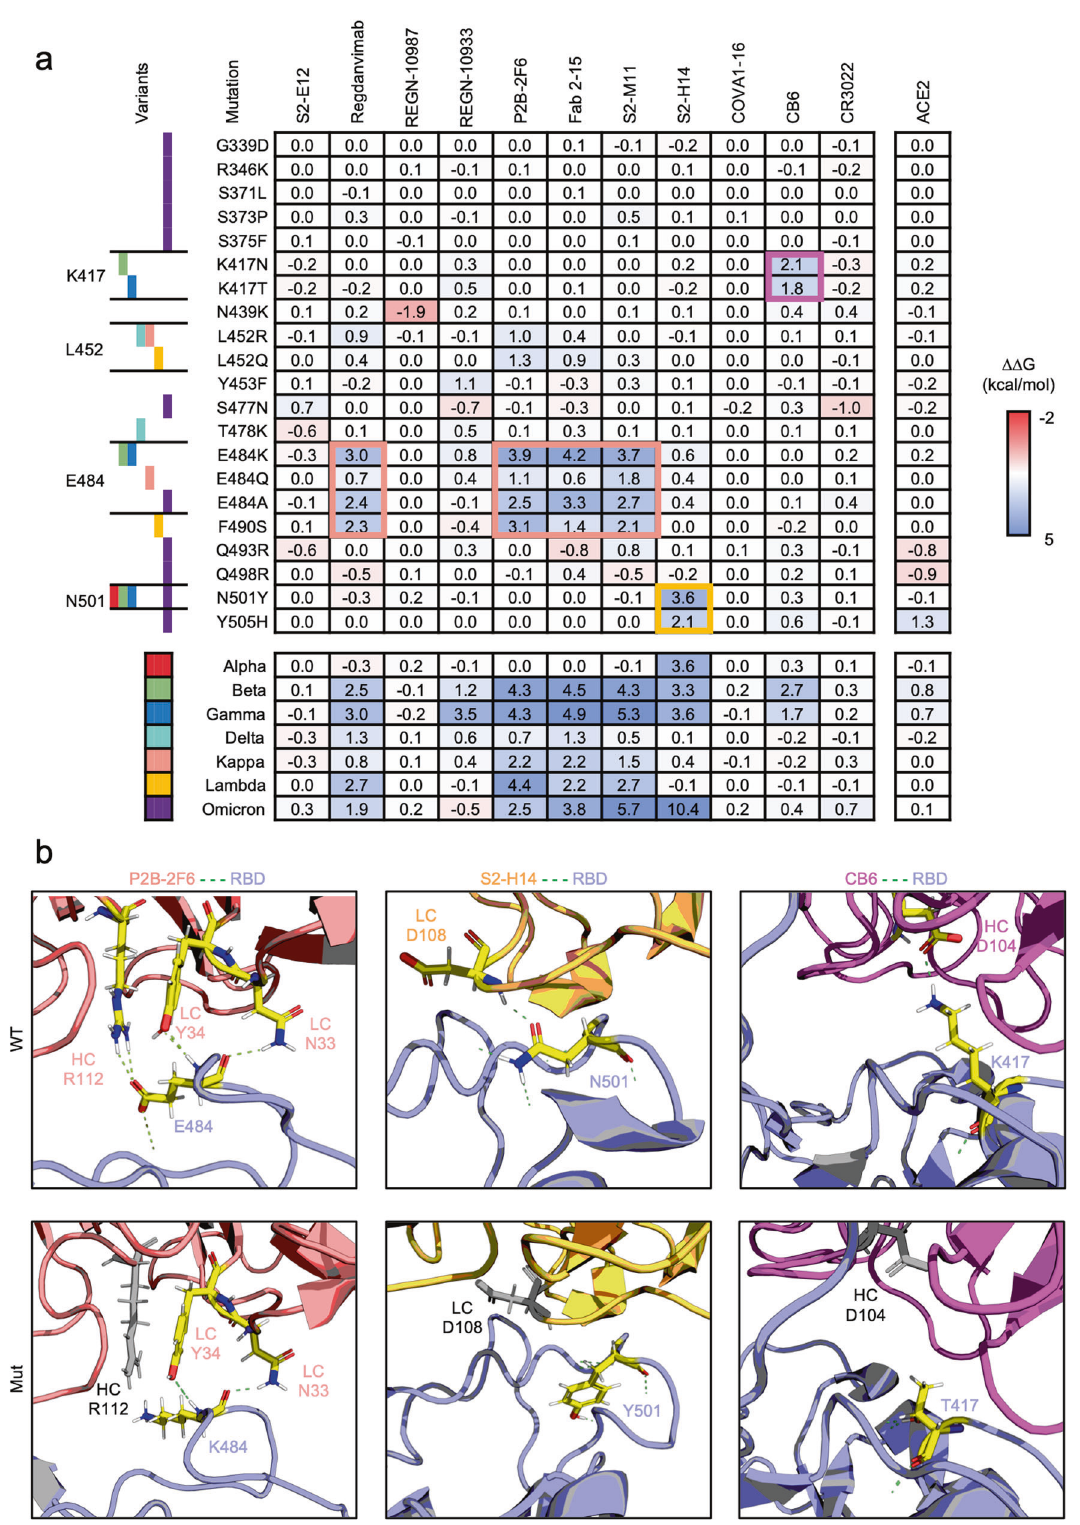
Fig. 1 Computational interface analysis of SARS-CoV-2 spike protein variants by FlexddG. a Interfacial free energy ( ΔΔ G) heatmap for complexes of neutralizing antibodies or ACE2 with RBD variants containing the indicated mutations. The ΔΔ G values are shown in the table. b Representation of the structural interface of the antibodies P2B-2F6, S2-H14, and CB6 with wild-type or mutated RBD. The interacting residues are shown as sticks and colored by atom (carbon: yellow, hydrogen: white, nitrogen: blue, oxygen: red). The hydrogen bonds are displayed as green dashed lines. Residues in antibodies that lost hydrogen bonds to the RBD due to the indicated mutations are gray. The shown ΔΔ G of each antibody or receptor in contact with the indicated mutation of the RBD is the average value from 35 output structures generated by fl exddG